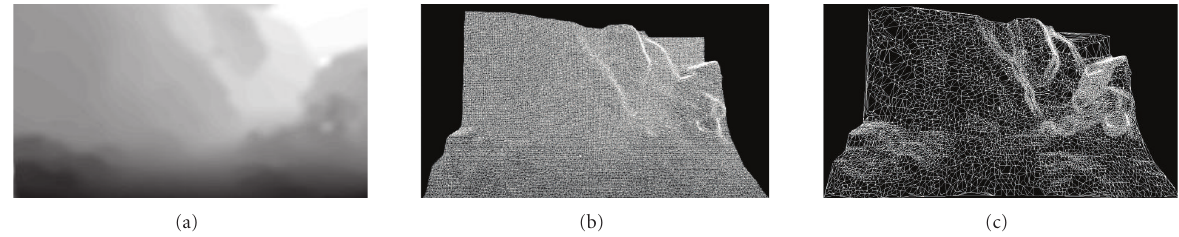
Figure 9: (a) Estimated disparity field corresponding to a local 3D model L k . (b) Resulting full 3D model produced when a nondecimated 2D triangulation of the geometric maps has been used. (c) Simplified 3D model of L k produced using a decimated 2D triangulation where the e max threshold has been set equal to 0.5